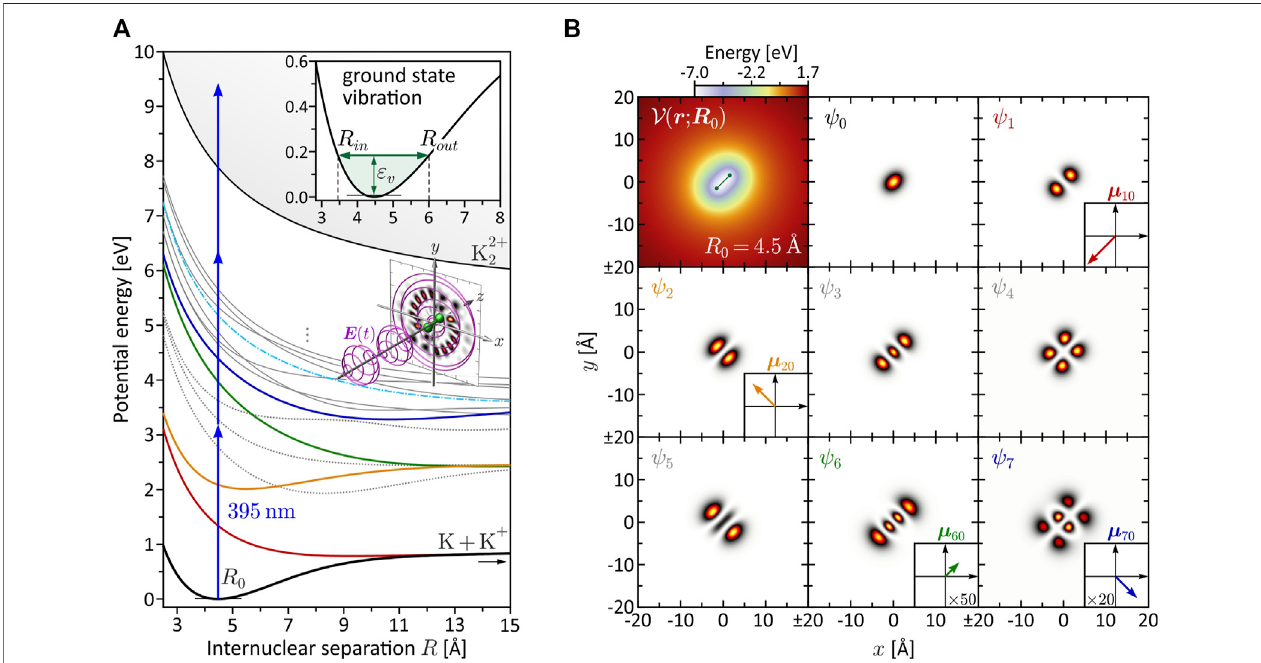
FIGURE1 | (Color online.)Characterizationof thebound molecular system. (A) BOpotentialenergy curves V n ( R ).The equilibrium distancein the electronic ground state is found at R 0 = 4.48 Å. Among the eight lowest states, only V 1 ( R ) (red), V 2 ( R ) (yellow), V 6 ( R ) (green) and V 7 ( R ) (blue) are dipole-coupled to the ground state. These states are relevant for the investigated MPI schemes. Especially state V 6 ( R ) plays a prominent role in the dynamic three-photon ionization scenario (see Section 3.2.2 ), because it becomes near-resonant with a pulse of central wavelength λ 0 = 395 nm at the outer turning point R out = 6.0 Å of the vibration (see inset). (B) Molecular potential V ( r ; R ) and fi rst eight electronic eigenfunctions ψ n ( r ; R ) for R = R 0 . The eigenfunctions are used to determine the transition dipole moments μ n 0 , coupling the states ψ n ( n ≥ 1) to the ground state ψ 0 , and to calculate the bound state population dynamics in the MPI scenarios.